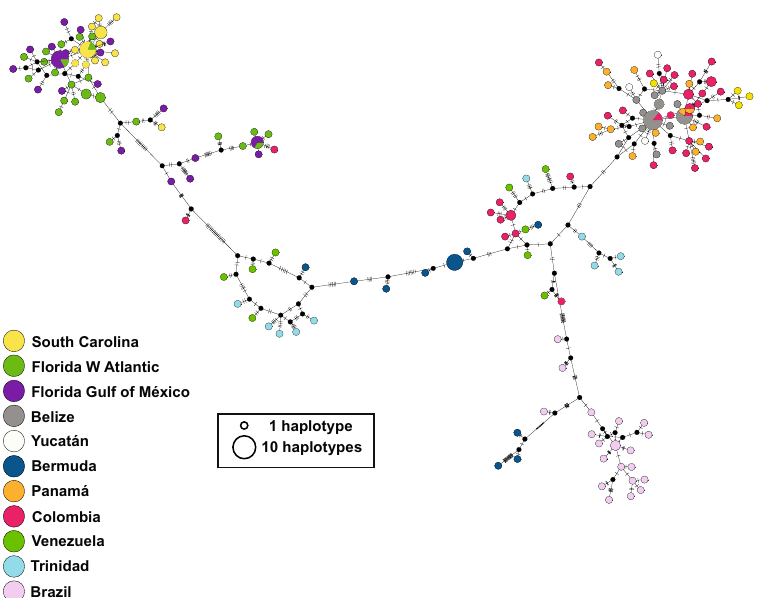
Figure 3. Median-Joining network of the West Atlantic clades of Petrolisthes armatus , based on concatenated haplotypes of 16S and two regions of COI. Colours indicate locality according to the legend, area of the circles illustrate the number of identical haplotypes, small black circles hypothetical ancestors or unsampled haplotypes, and hatch marks represent the number of mutations by which haplotypes